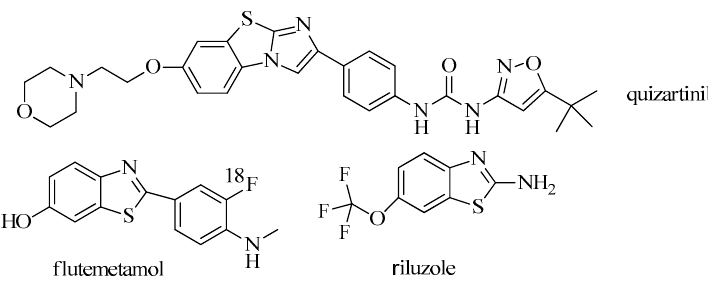
Figure 1. Drugs approved by